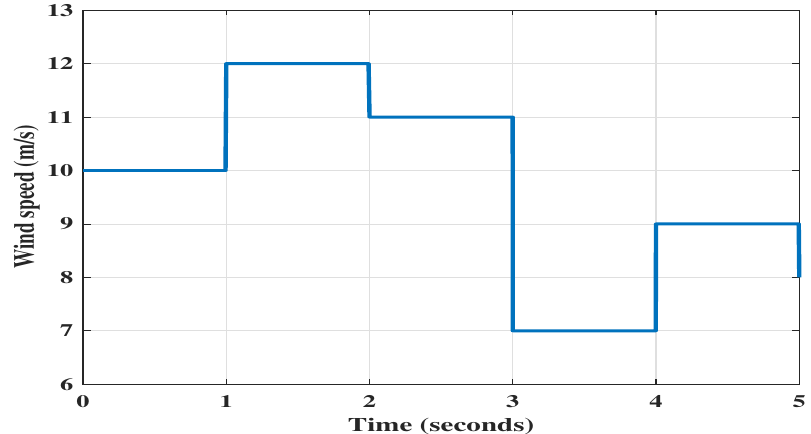
Figure 14. Variable wind